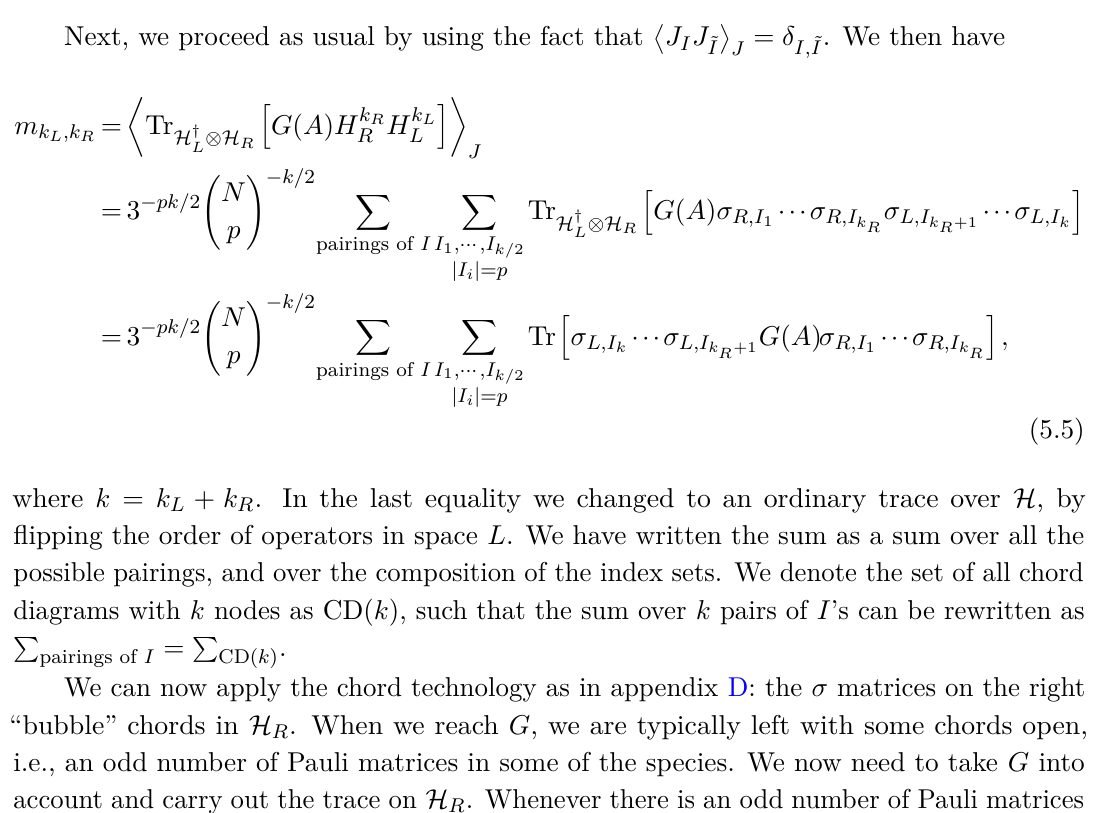
( A ) σ R,I 1 σ R,I 2 σ R,I 3 σ R,I 2